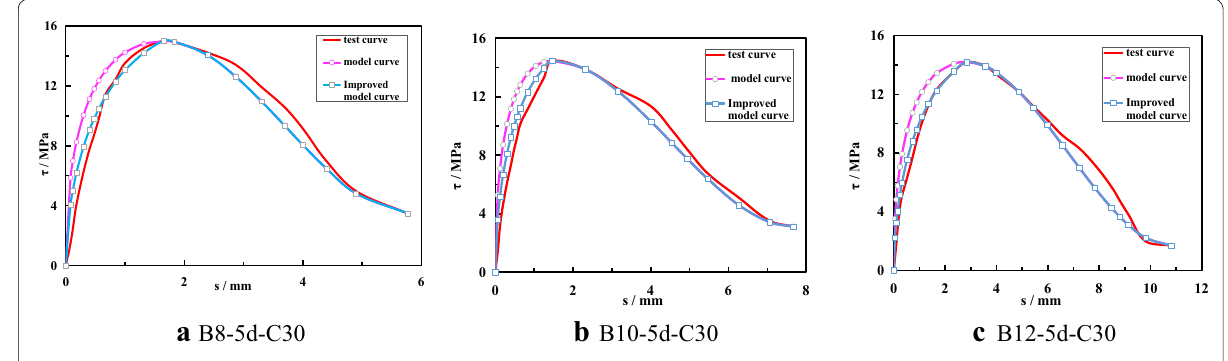
Fig. 13 Comparison of τ - s test curve and curves from bon-slip